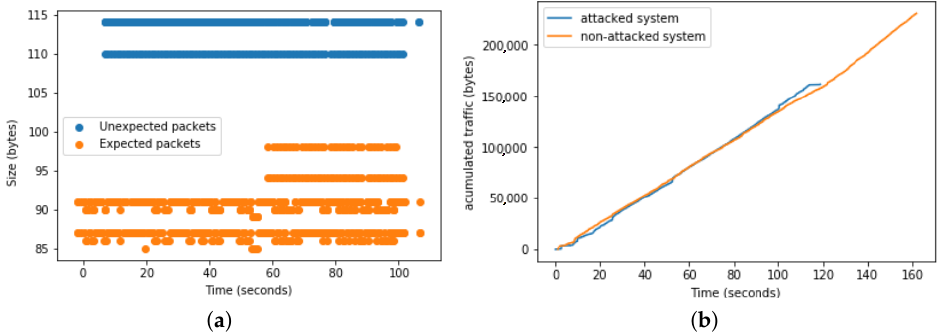
Figure 6. Trash injection attack evaluation diagrams. ( a ) Expected against unexpected packets. ( b ) Cumulative traffic of baseline scenario vs. trash injection attack